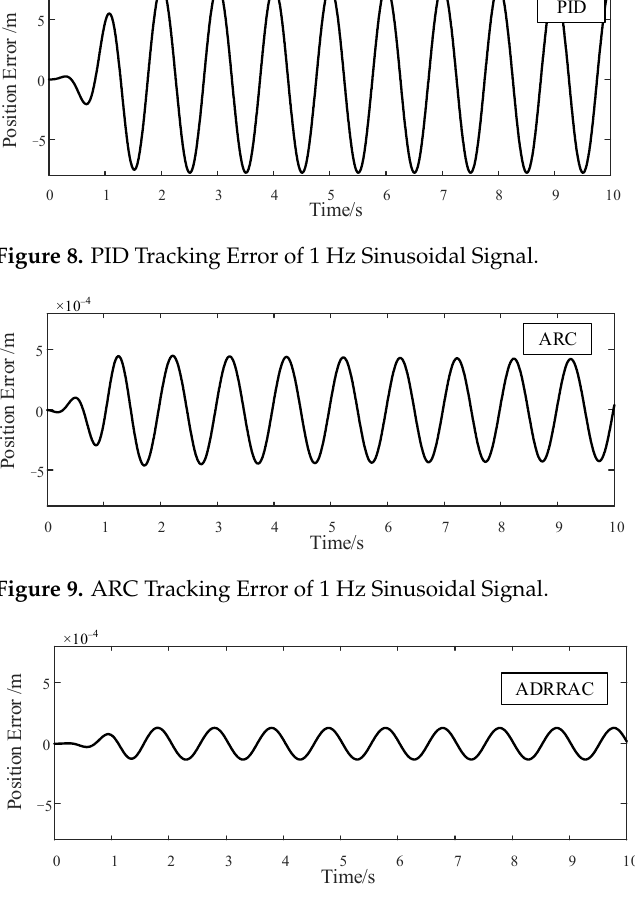
Figure 11. PID Tracking Error of 1 Hz Sinusoidal Signal with 700 N External Disturbance.